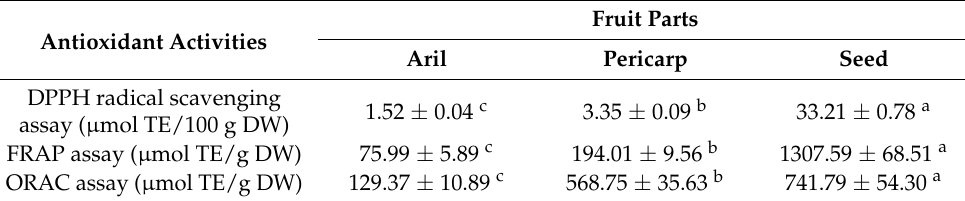
Table 5. Antioxidant activities of different fruit parts of Nephelium hypoleucum Kurz. Antioxidant Activities